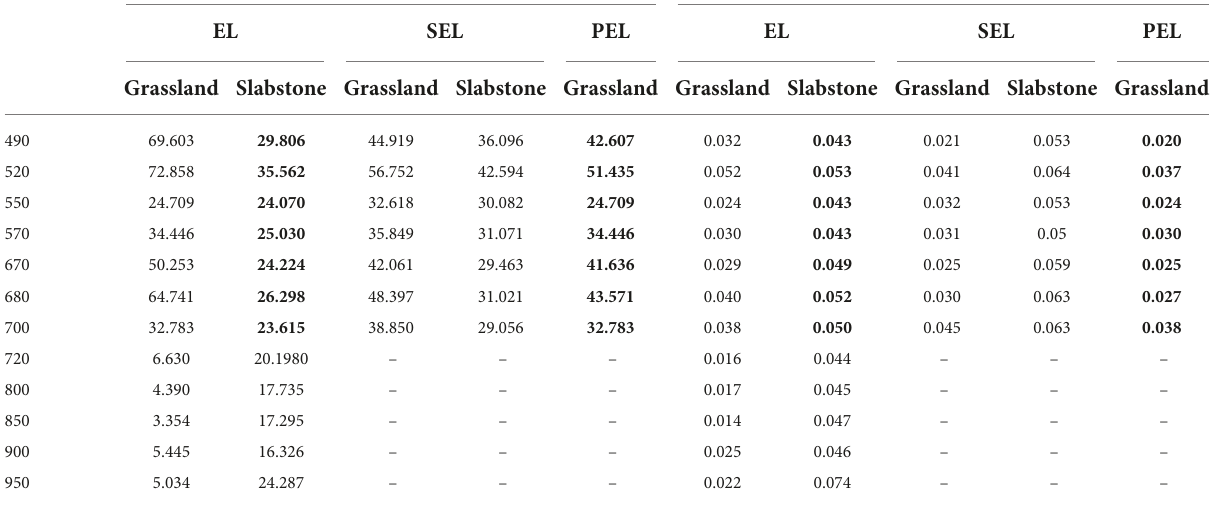
TABLE 3 Statistical results of reflectance accuracy of different RCMs in Test